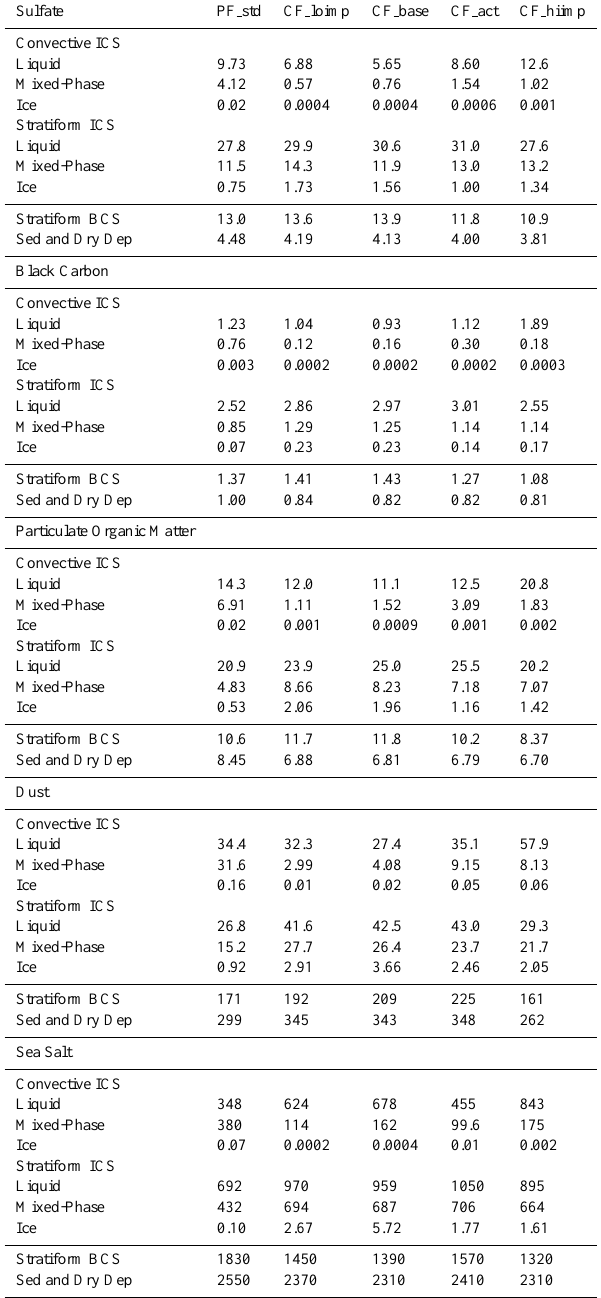
Table 3. Global and annual mean deposition budgets for sulfate, black carbon, particulate organic matter, dust and sea salt (Tgyr − 1 , except TgSyr − 1 for sulfate) for the five simulations presented in Table 1. Liquid refers to cloud temperatures warmer than 273K, mixed-phase refers to temperatures between 273K and 238K, and ice refers to temperatures below 238K. ICS: in-cloud scavenging, BCS: below-cloud scavenging, Sed and Dry Dep: sedimentation and Dry